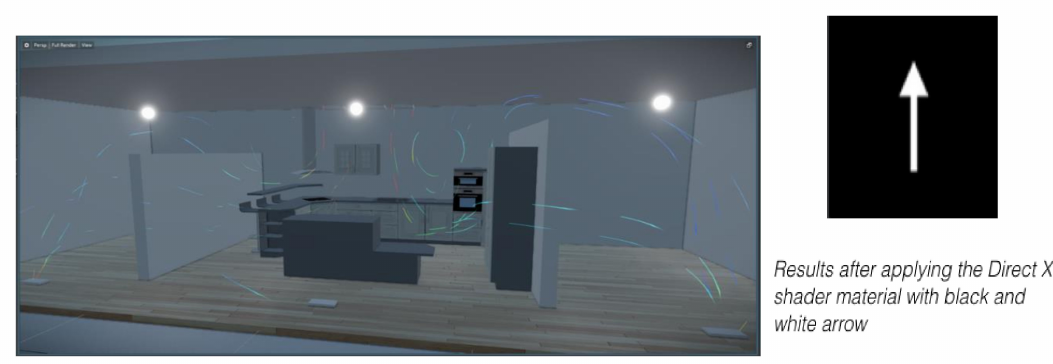
Figure 14. Wind flow animation with arrow ( left ); the arrow colormap ( right